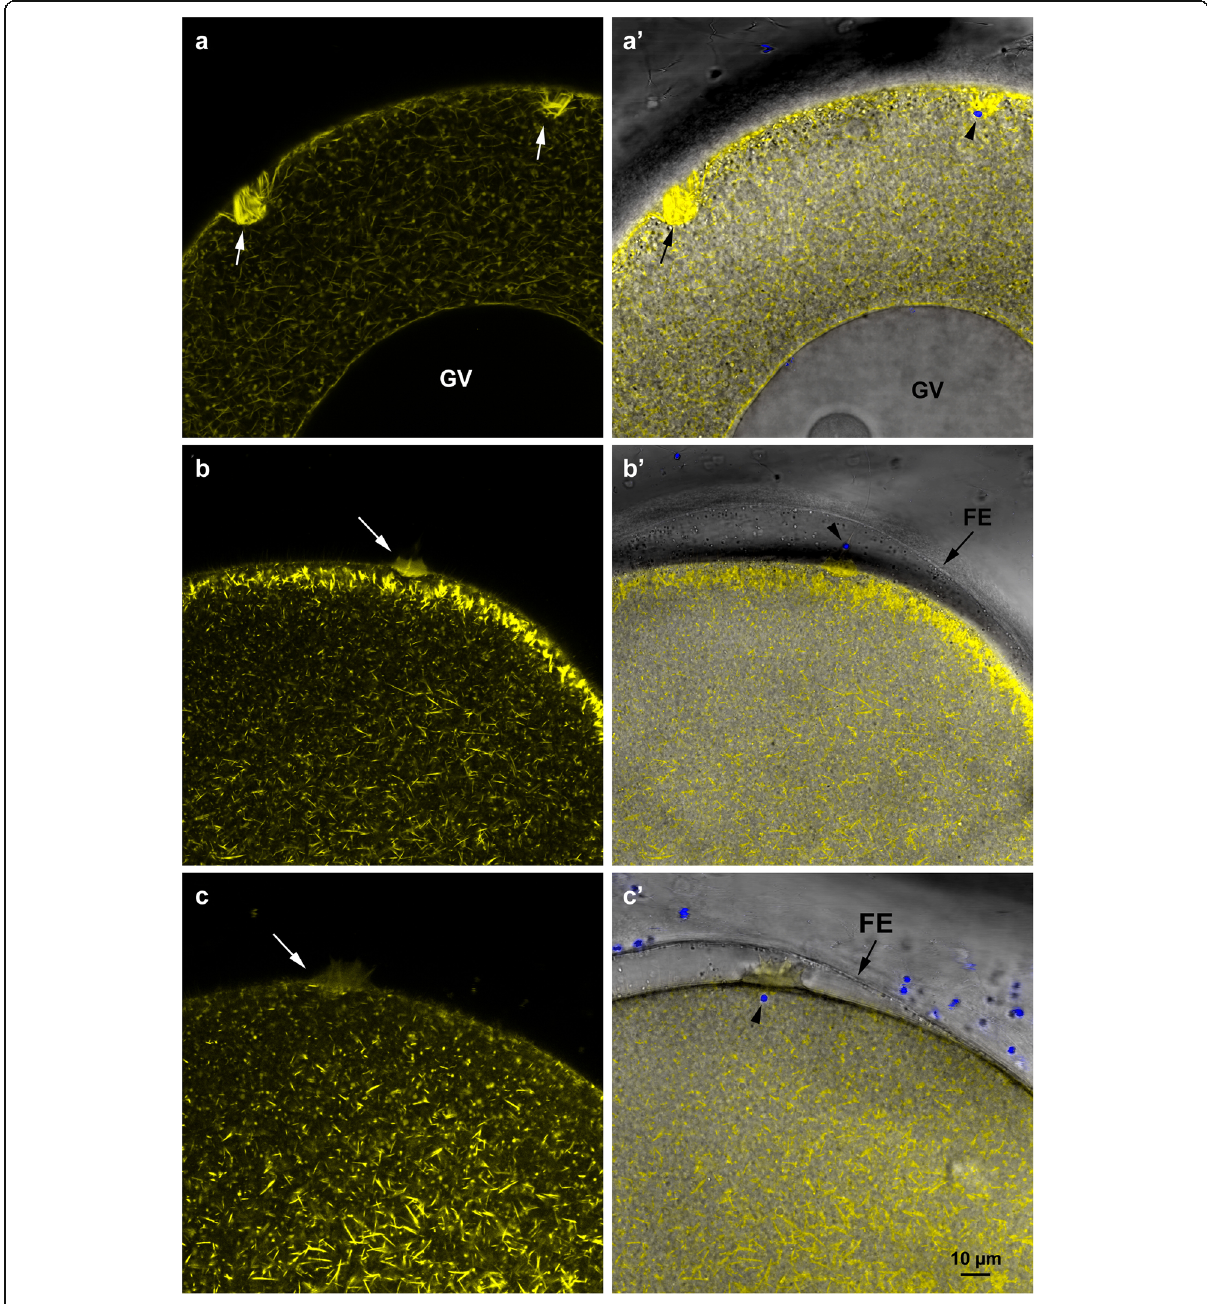
Fig. 6 Confocal images of the cortical actin cytoskeleton in starfish oocytes fertilized at different meiotic stages. Immature oocytes, mature eggs and overripe eggs of A. aranciacus were microinjected with Alexa Fluor 568 phalloidin. a F-actin staining of the fertilization cones in a polyspermic immature oocyte. Note the large number of actin bundles composing the fertilization cones that will incorporate the sperm in the absence of a FE elevation shown in the overlay image in a ’ . b A mature monospermic egg fertilized in its optimal stage of maturation (70 min 1- MA treatment) that shows a fertilization cone. Note the initiation of the centripetal translocation of individual actin fibres at the subplasmalemmal zone and the elevation of the FE in the overlay image in b ′ as a result of the CG exocytosis. c Reorganization of the F-actin in an overripe egg fertilized after 6 h hormonal treatment. Note that the centripetal translocation seen in fertilized mature eggs is absent in overripe eggs upon insemination. c ′ ) Image overlay showing the fertilization envelope (FE) elevation and incorporation of sperm in the egg (arrowhead). Multiple spermatozoa enter even in the presence of normal elevation of